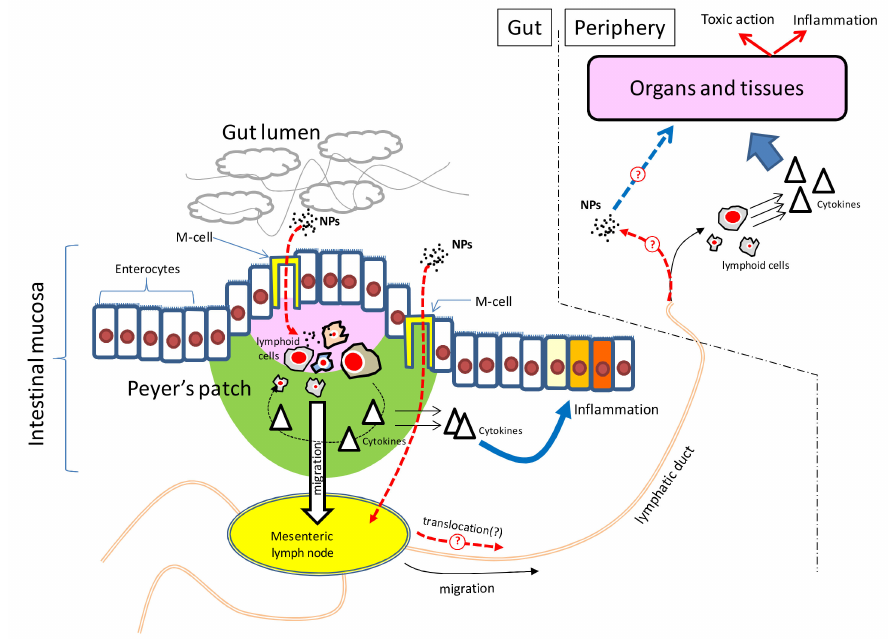
Figure 7. Hypothetical mechanism of SiO 2 NPs’ immunotoxic action at an oral way of